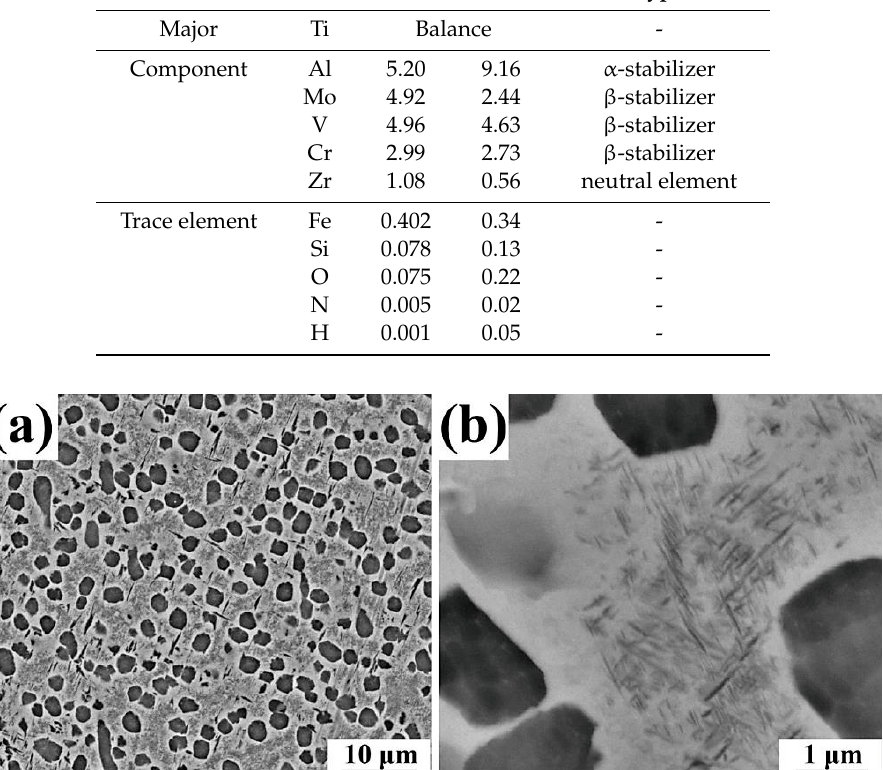
Figure 1. SEM back-scattered electron images of the as-received bimodal Ti-55531 alloy: ( a ) overview; ( b ) enlarged.